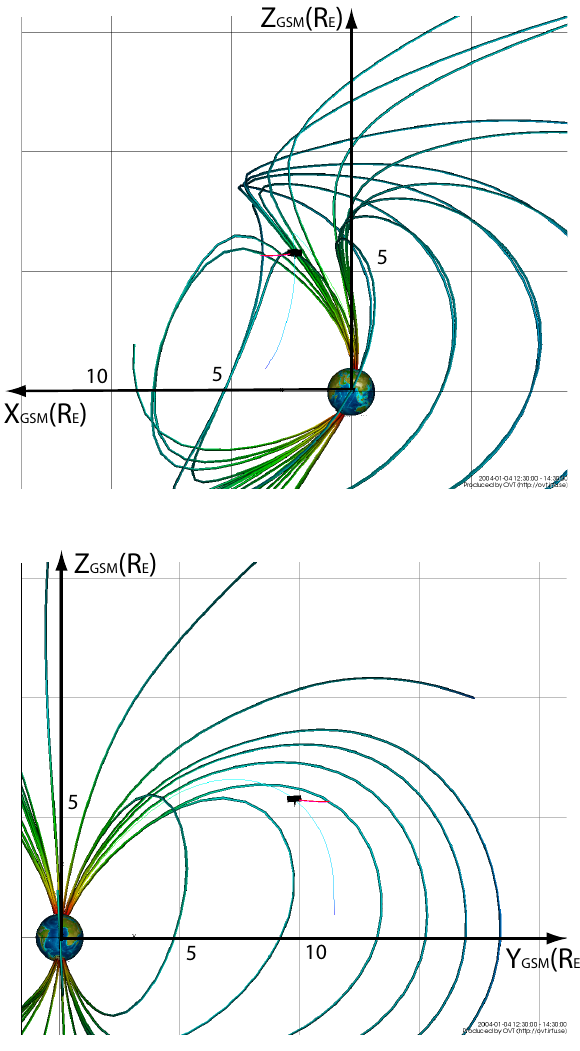
Fig. 2. Cluster orbit on 4 January 2004, 12:30–14:30UT. During this time interval Cluster moved from [2.3 9.8 5.7] R E (GSM) to [3.7 11.2 5.7] R E (GSM). The maximum separation between the spacecraft is ∼ 300km. The plot was created using OVT (http://ovt.